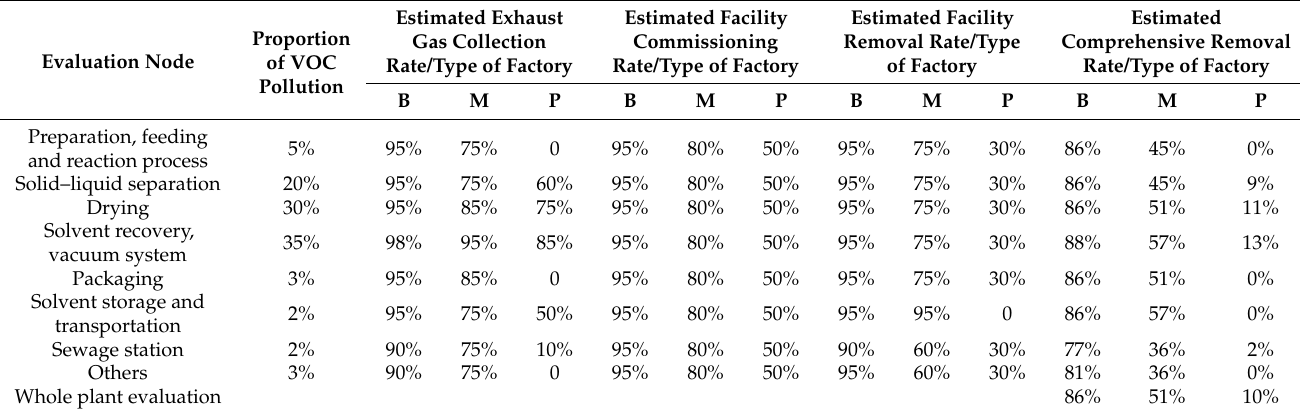
Table 8. Classification of comprehensive removal rates in the pesticide industry (B represents benchmark, M represents moderate, and P represents